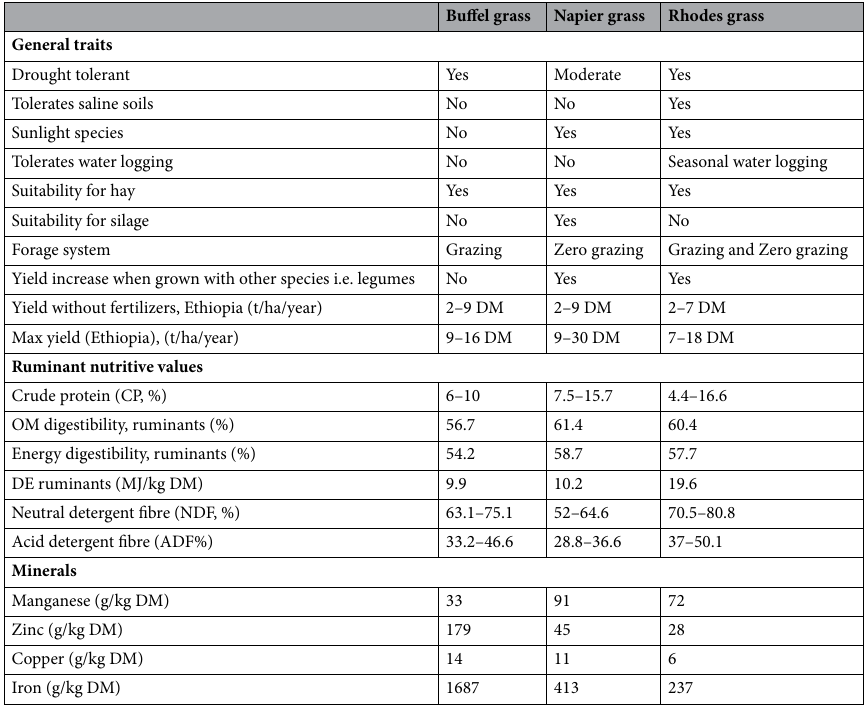
Table 1. Traits of Buffel, Napier and Rhodes grass grown under conditions currently prevalent in sub-Saharan Africa 20–29